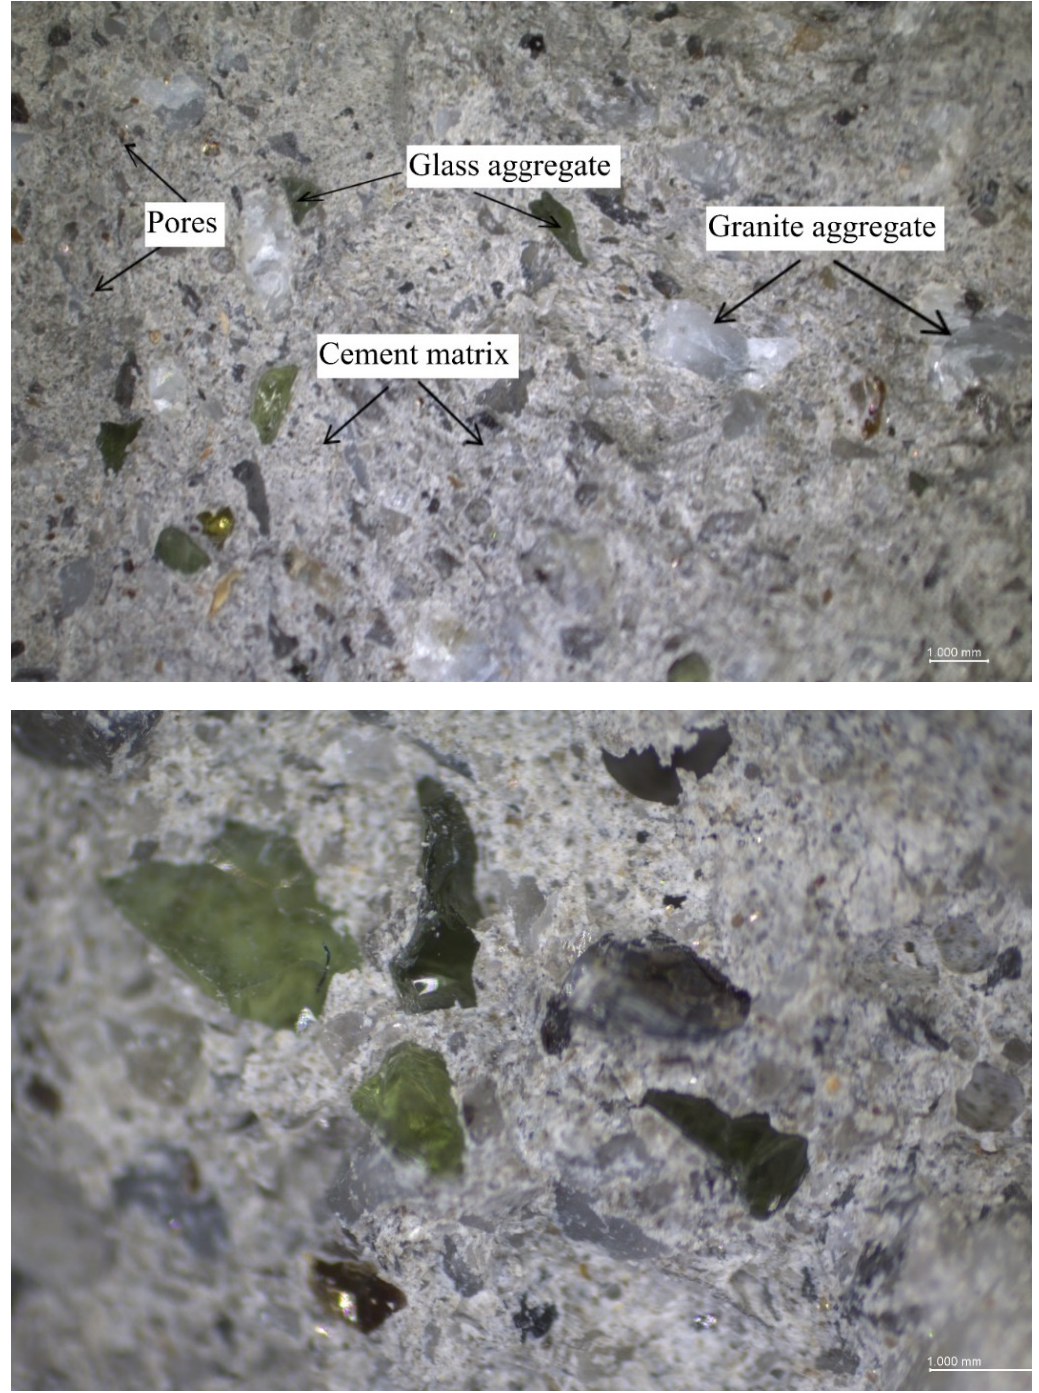
Figure 11. Light microscope images of microstructure of mortar with 10% of glass cullet.